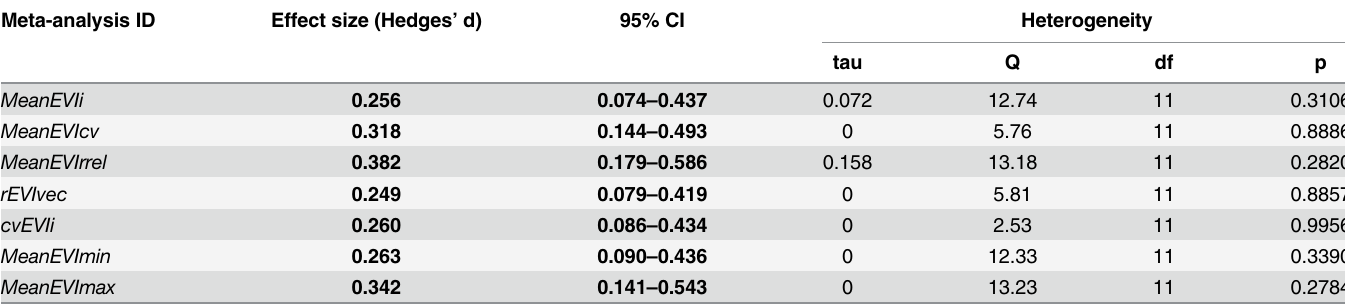
Table 1. Effect sizes for EVI